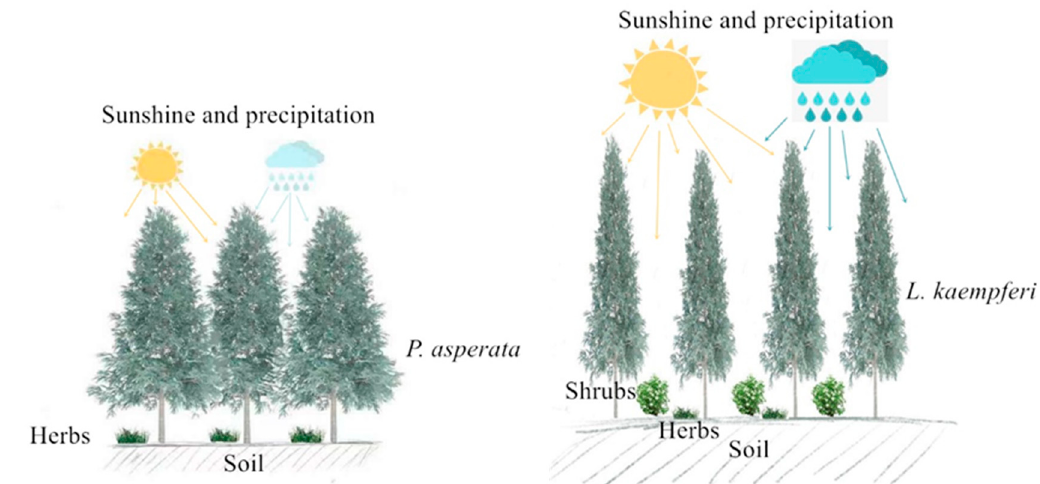
Figure 8. Conceptual figure of P. asperata and L. kaempferi forest, where less sunshine and precipitation can reach to ground in P. asperata forest than in L. kaempferi forest.